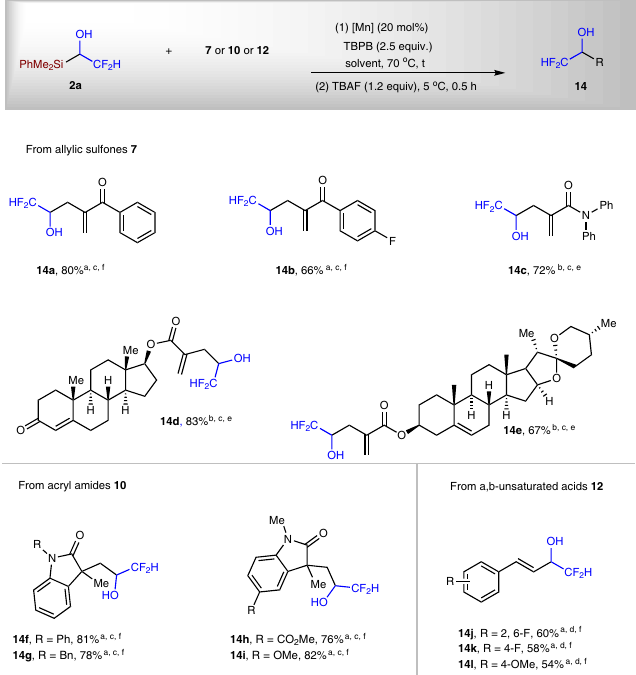
Fig. 7 Synthesis of α -di fl uoromethylated alcohols. a Mn(OAc) 3 ·2H 2 O (20 mol%) was used as catalyst. b Mn(OAc) 2 ·4H 2 O (20 mol%) was used as catalyst. c DCM (0.1 M) was used as solvent. d Hexane (0.4 M) was used as solvent. e t = 18 h and f t = 14